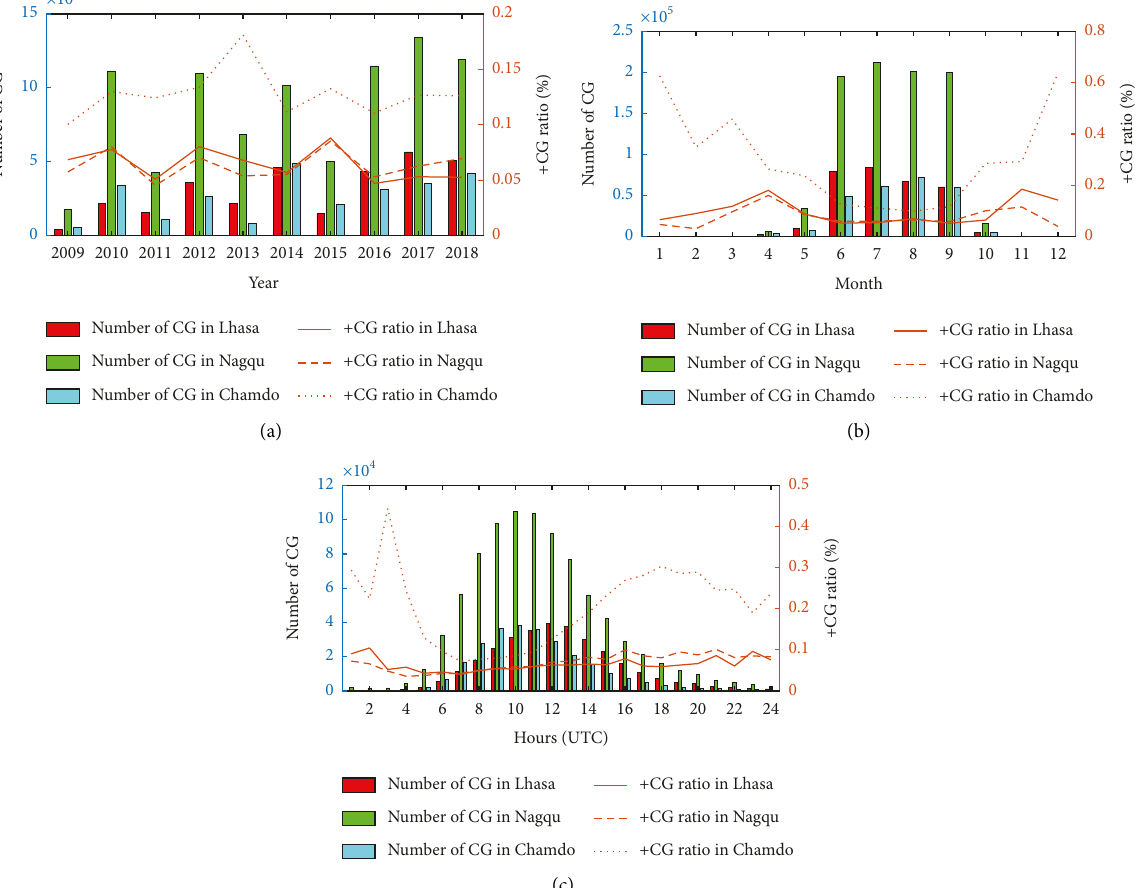
Figure 7: The (a) annual, (b) monthly, and (c) daily distributions of CG lightning in the areas of Lhasa, Nagqu, and Chamdo from 2009 to